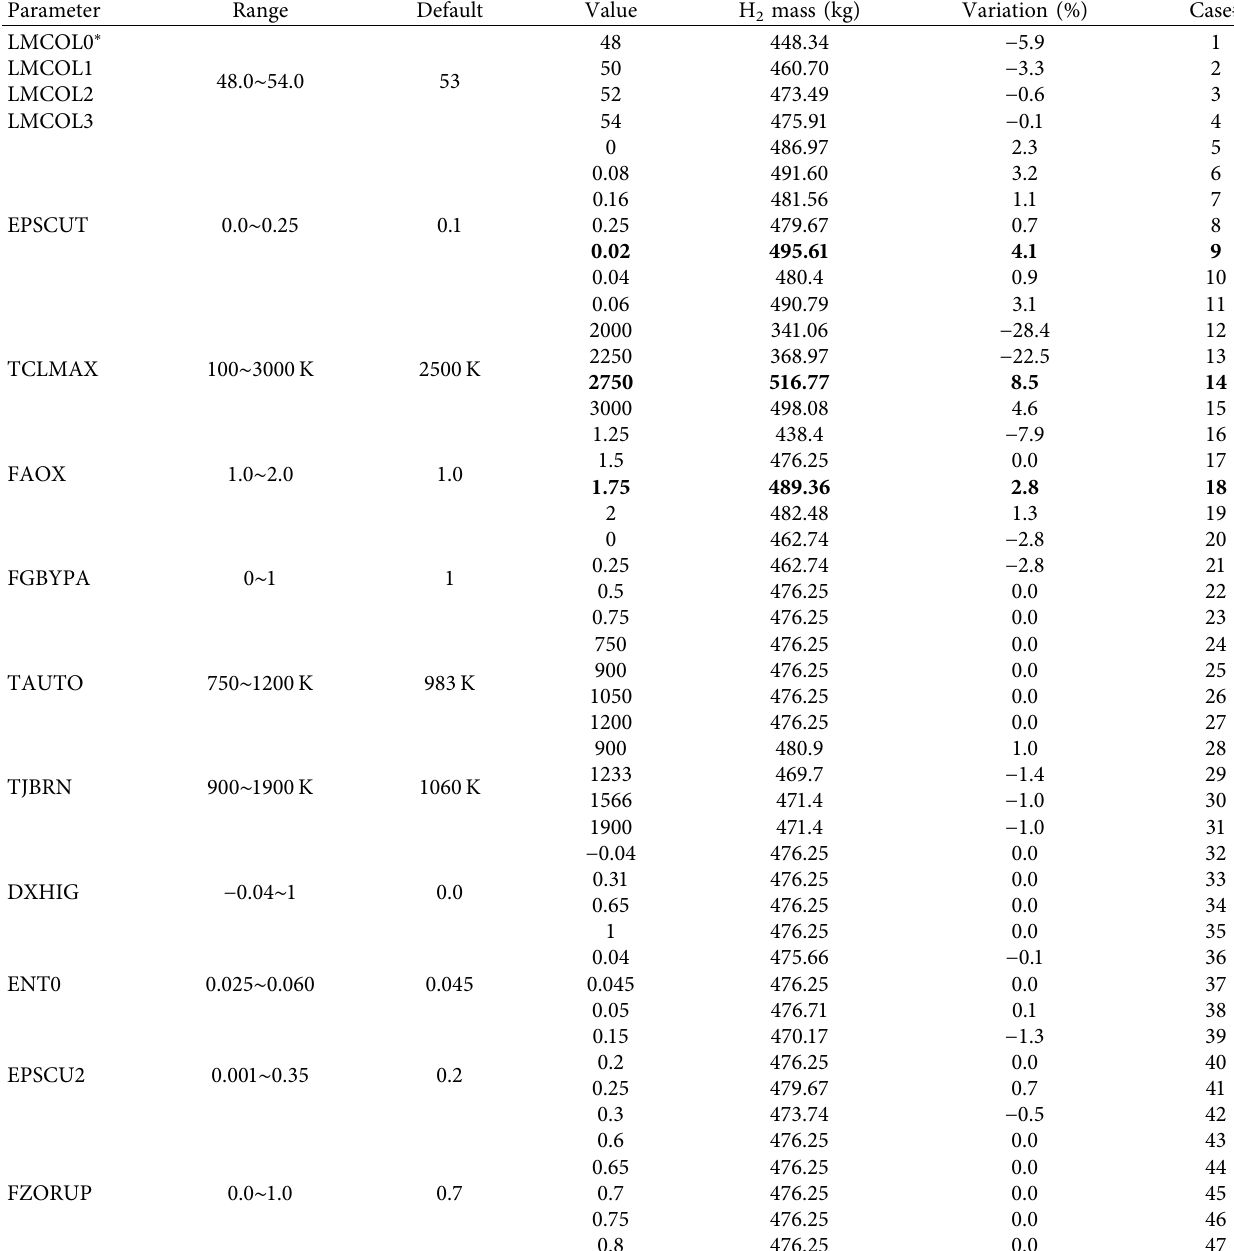
Table 12: Effect of MAAP parameters (phenomenological